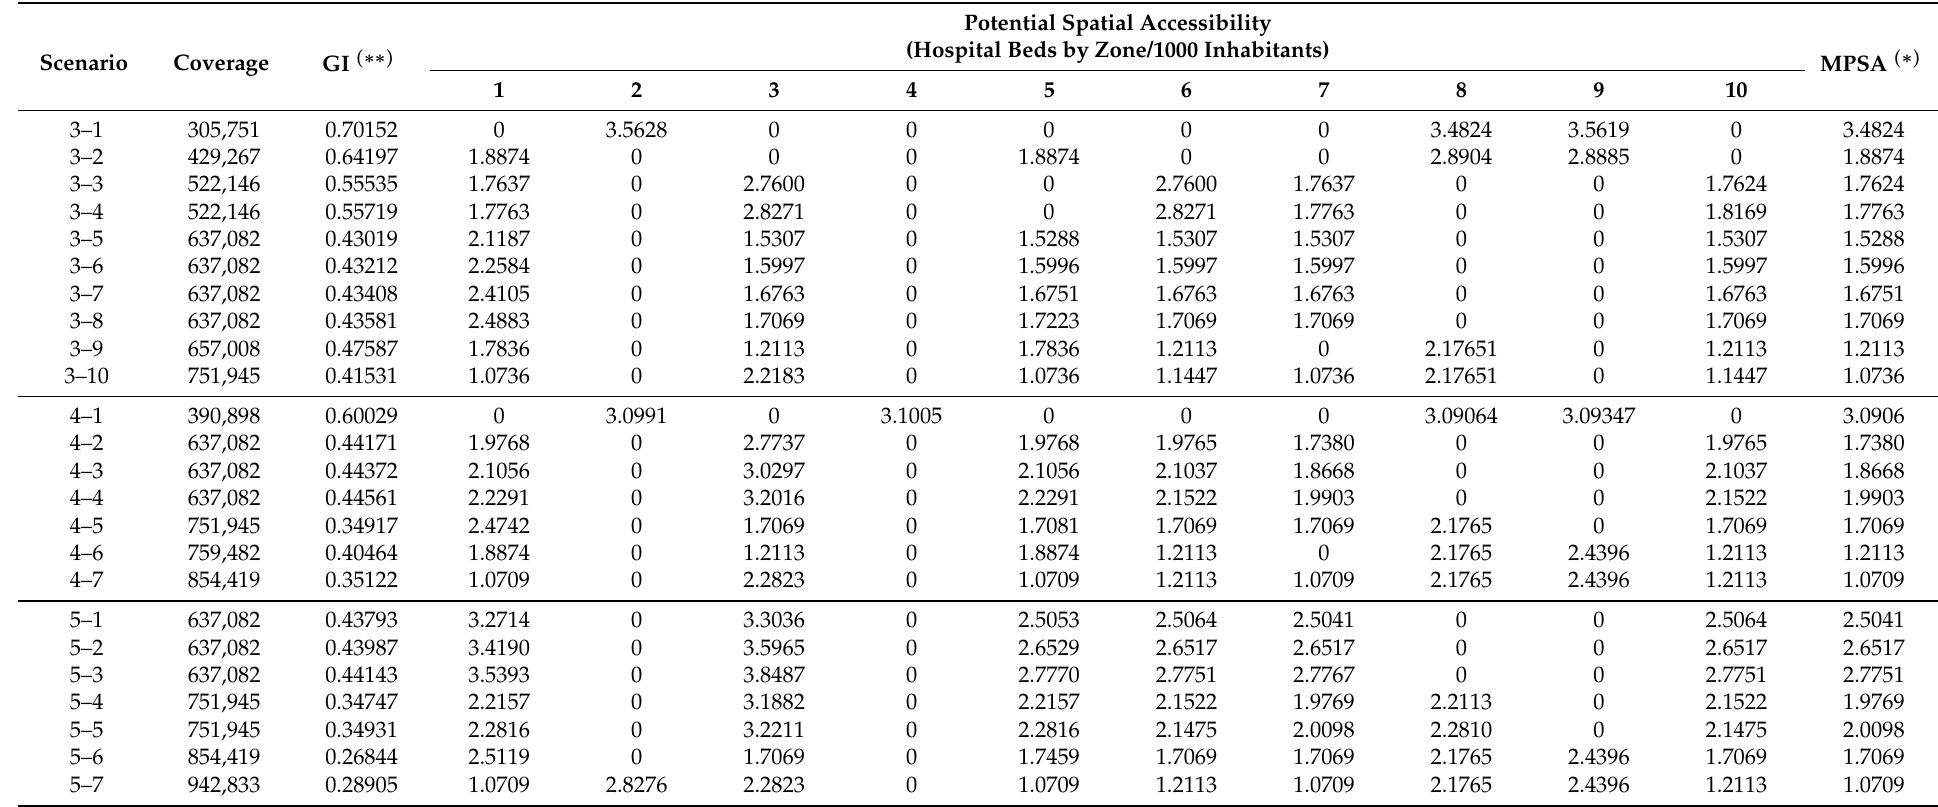
Table 5. Objective values in the listed scenario, zone, and other indicators for instance